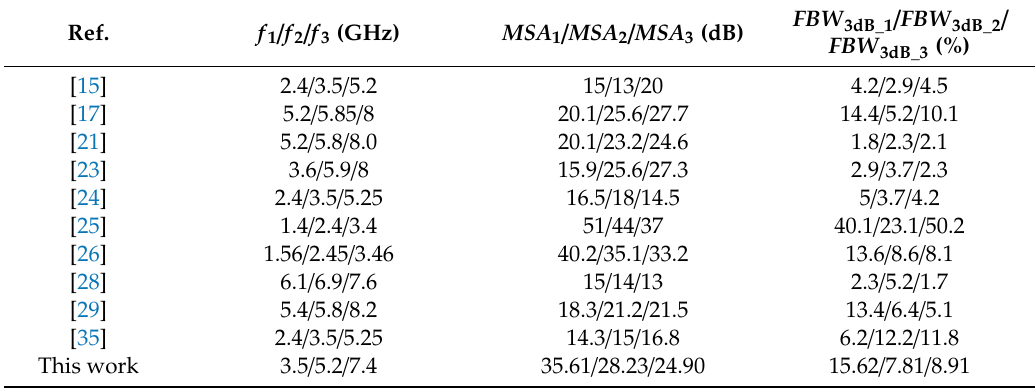
Table 4. Comparison of the proposed filter with other triple notches bandstop microstrip filters.